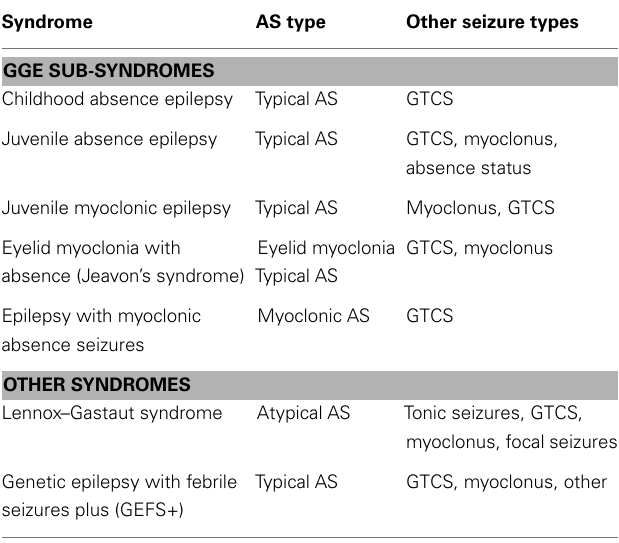
Table 1 | ILAE-defined syndromes in which absence seizures are commonly observed